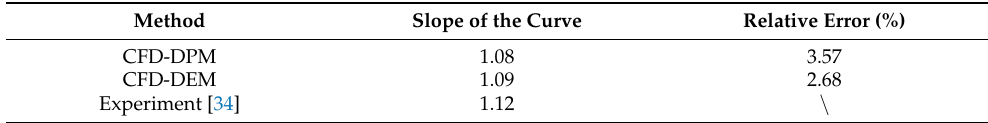
Table 3. Comparisons of slope of the efficiency curves obtained from CFD-DPM method, CFD-DEM method, and the experimental result [34] in Figure